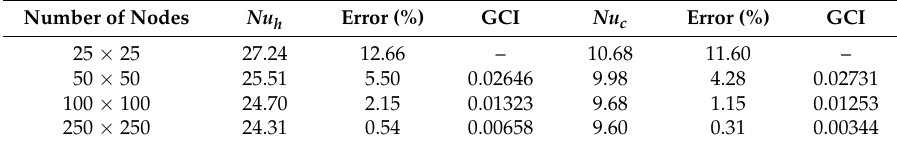
Table 3. Nusselt number Nu for the vertical walls with the grid convergence indexes (GCI).